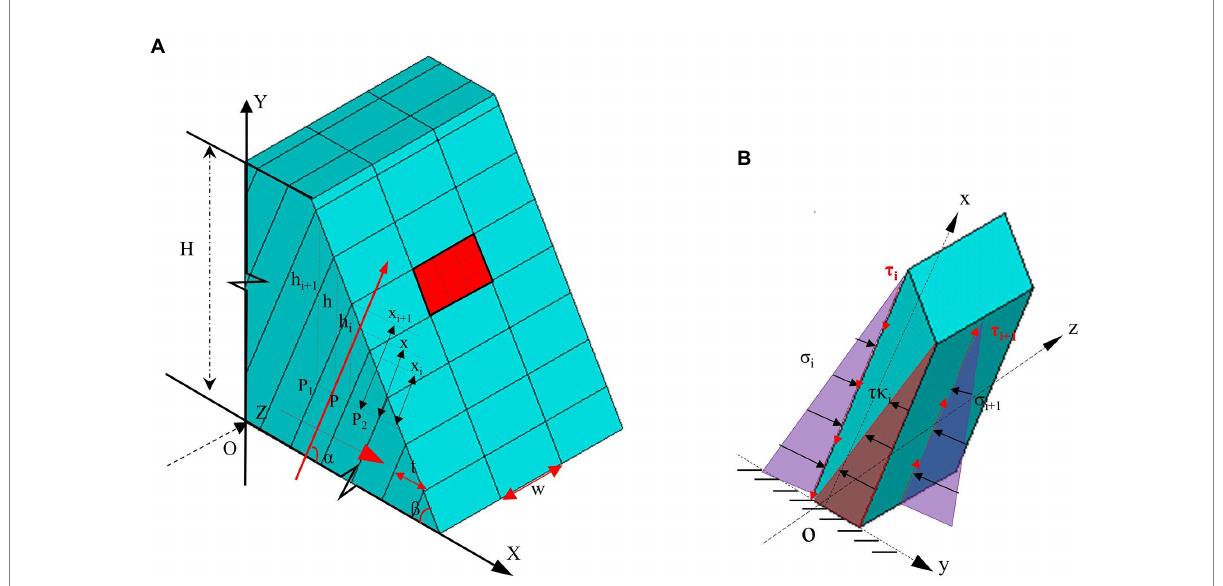
FIGURE 8 Relationship between toppling fracture depth and width and thickness of the slab beam.